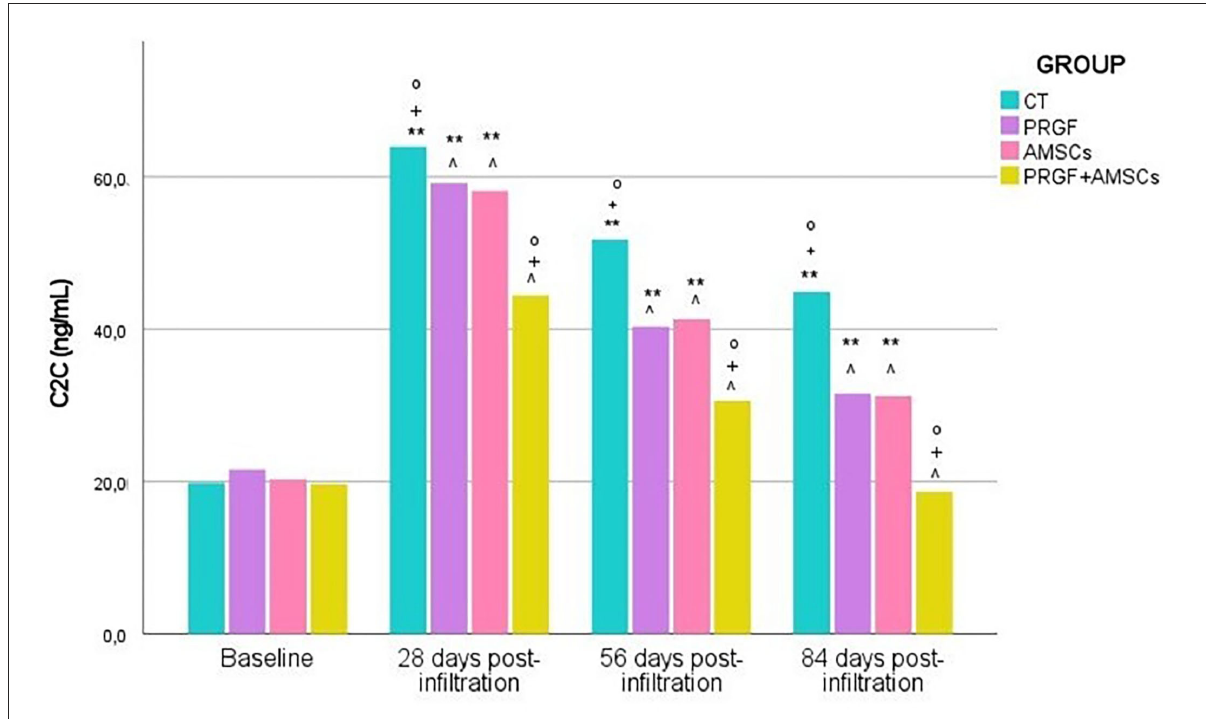
FIGURE3 C2C serum concentration (ng/mL) before infiltration and 28-, 56-, and 84-days post-infiltration in all treatment groups. C2C, type II collagen cleavage neoepitope; CT, control; PRGF, plasma rich in growth factors; AMSCs, adipose mesenchymal stem cells; PRGF + AMSCs, combination of plasma rich growth factors with adipose mesenchymal stem cells. ∧ , significant differences with CT group; ◦ , significant differences with PRGF group; + , significant differences with AMSCs group; **, significant differences with PRGF + AMSCs group.